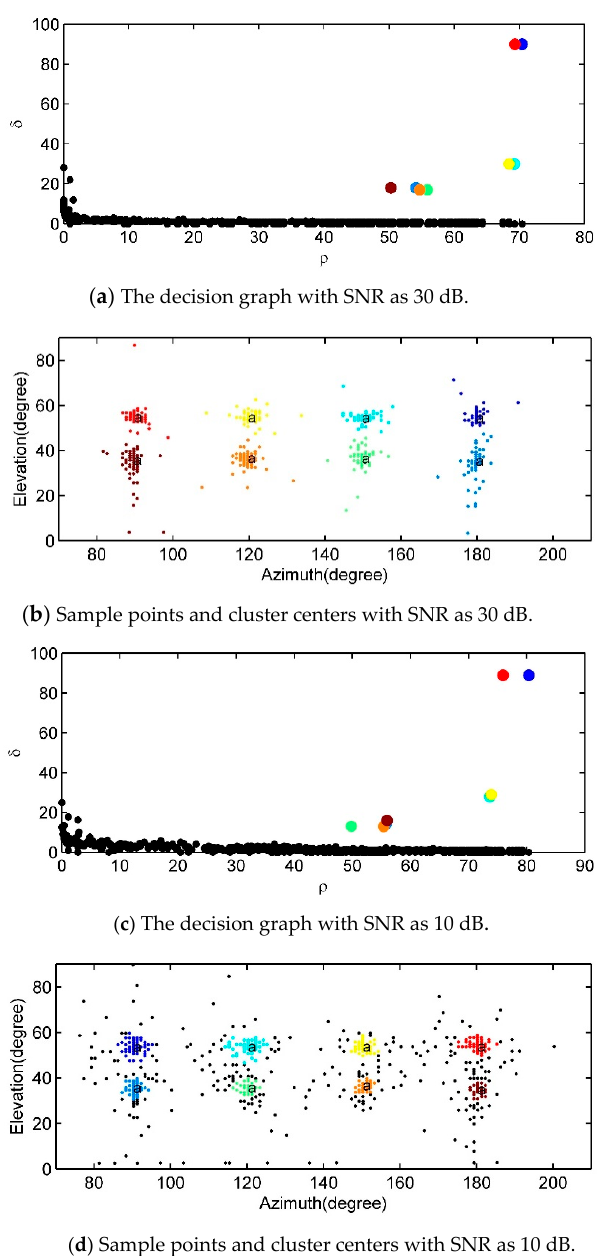
( b ) 10 dB Figure 5. Sample points obtained by the first 100 frames with different SNR . DPC was used for analyzing the sample points to accurately localize the sound source. In Figure 6, the identified cluster centers (sound sources) are marked as a with the reverberation time being 300 ms and the SNR being 10 dB and 30 dB respectively. Tables 1 and 2 give out the identified coordinates of cluster centers with the reverberation time as 300 ms corresponding to different SNRs and the SNR as 30 dB under different rever-